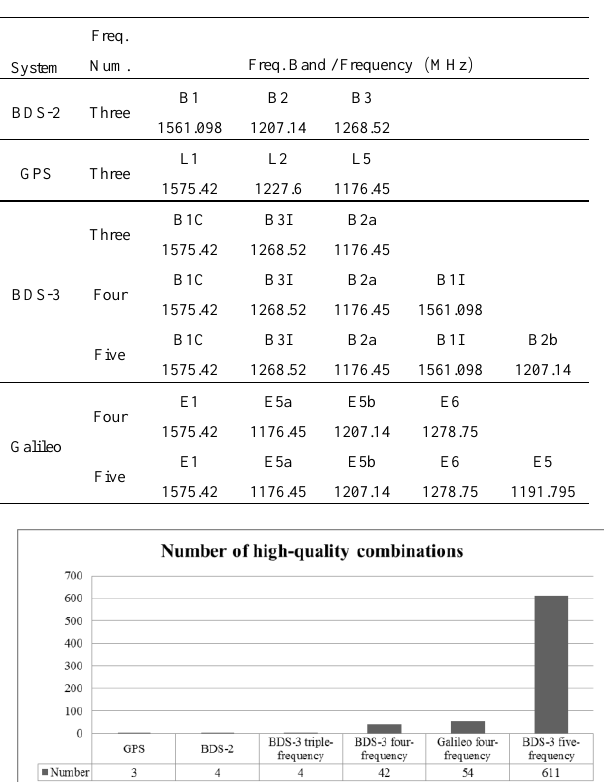
Table 1. Frequency band and frequency of multi-GNSS and multi-frequency (unit: MHz)